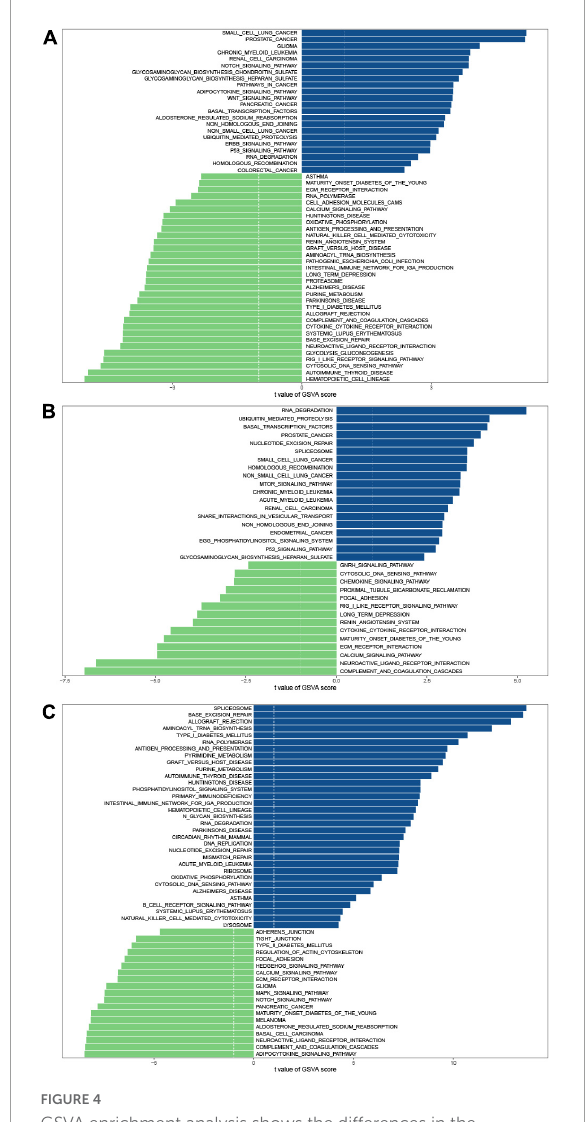
FIGURE4 GSVA enrichment analysis shows the differences in the underlying biological processes between the three m 6 A patterns. (A) Pattern B vs. Pattern A. (B) Pattern C vs. Pattern A. (C) Pattern C vs. Pattern